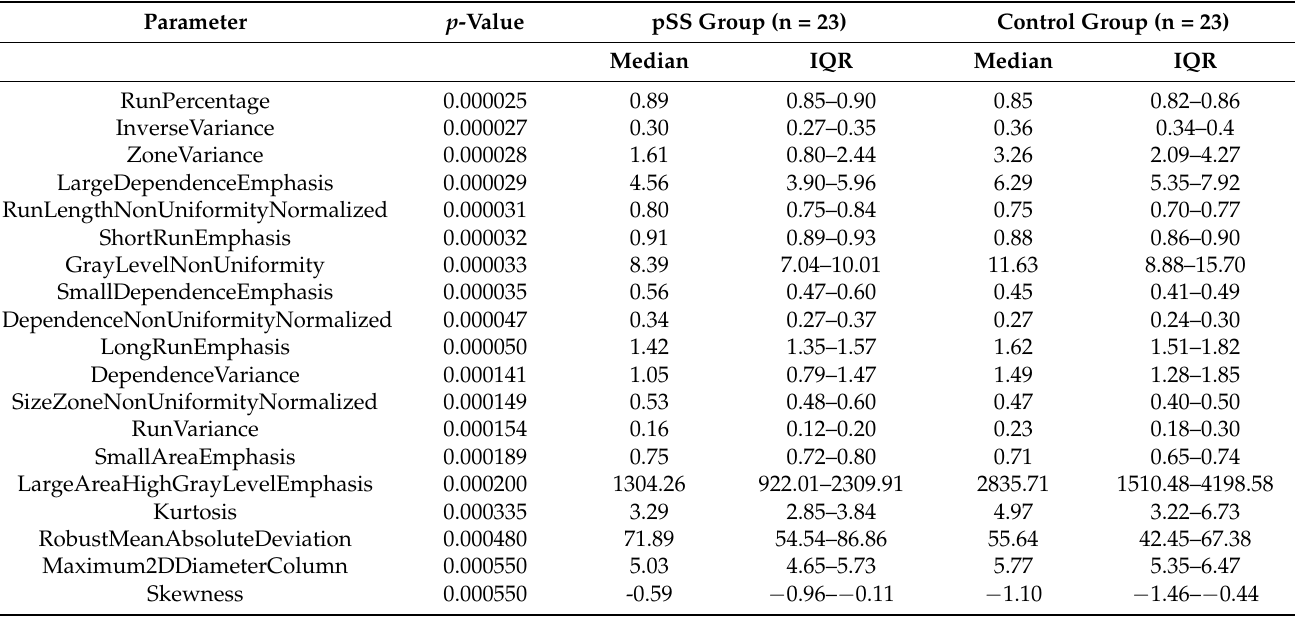
Table 2. Textural features that show statistically significant results at the univariate analysis between patients with pSS and healthy subjects.